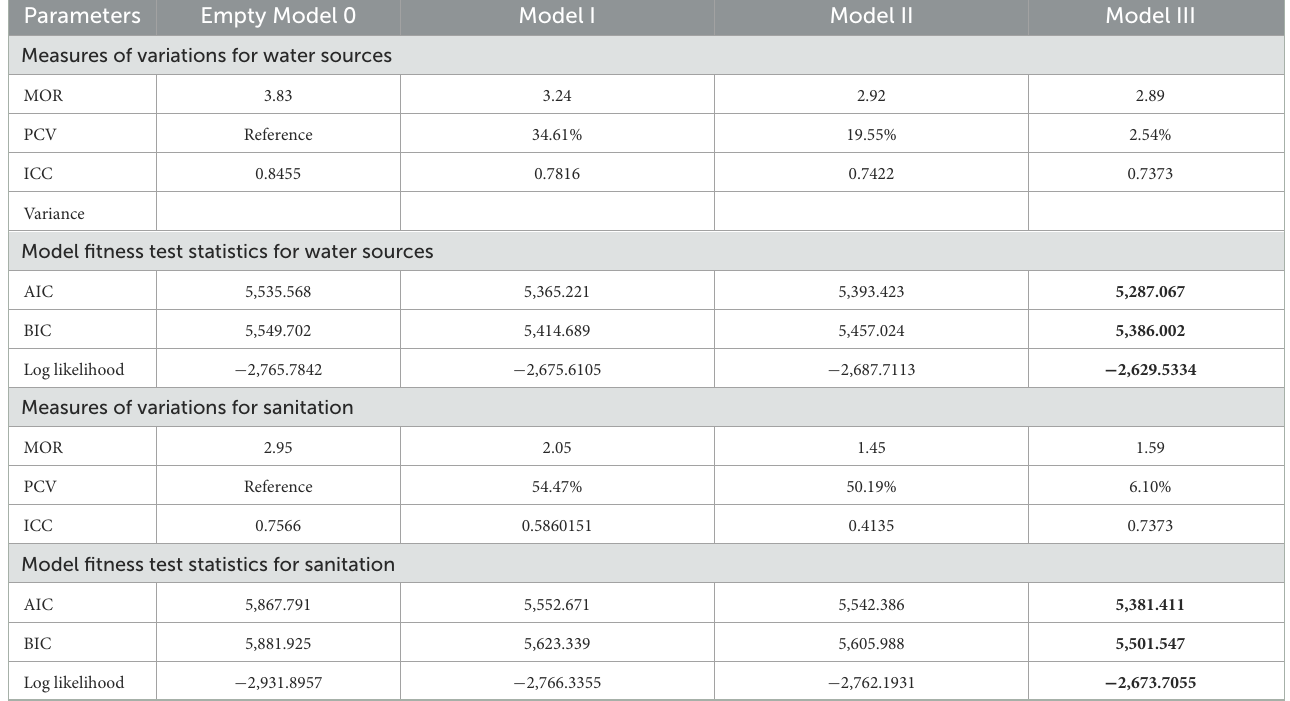
TABLE 4 Measures of variation and model fitness for both improved water source and sanitation in Ethiopia.